Question: What kind of plot is shown here?
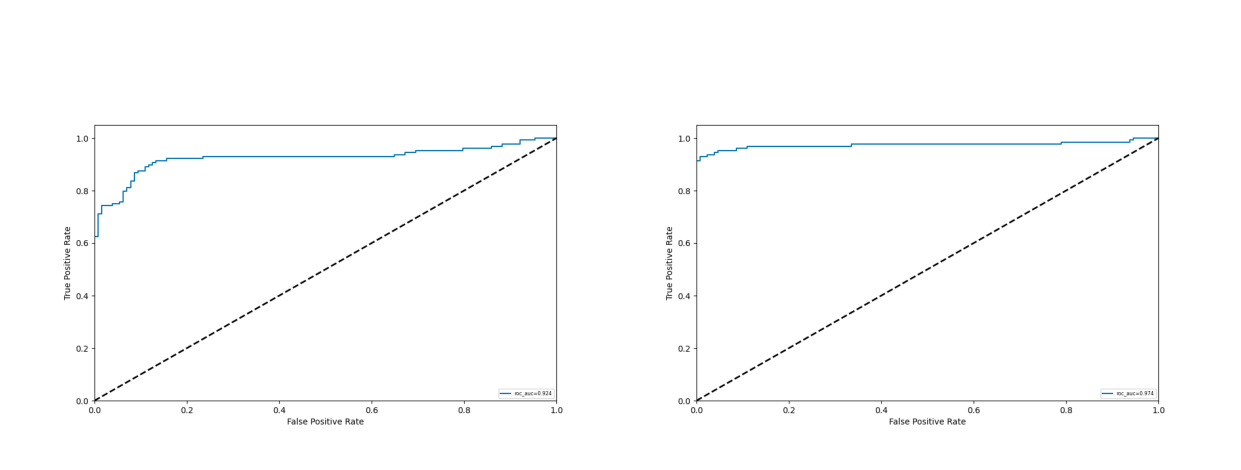
Answer: line